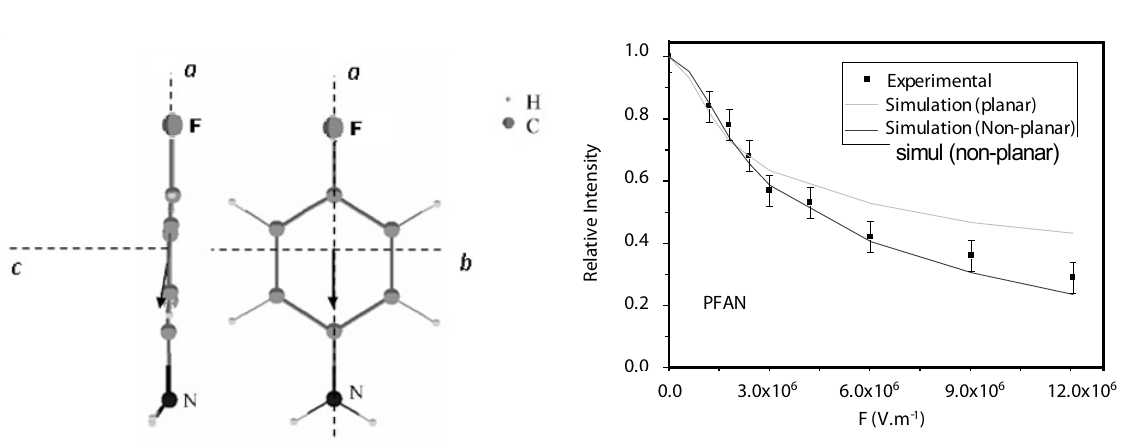
Figure 4. Relative intensity of the beam profile on the beam axis as a function of the electric field F for PFAN molecules. Squares correspond to experimental data and the lines to the rigid rotors quantum simulations performed using dipole values and rotational constants for planar and non-planar structures (see Table 1